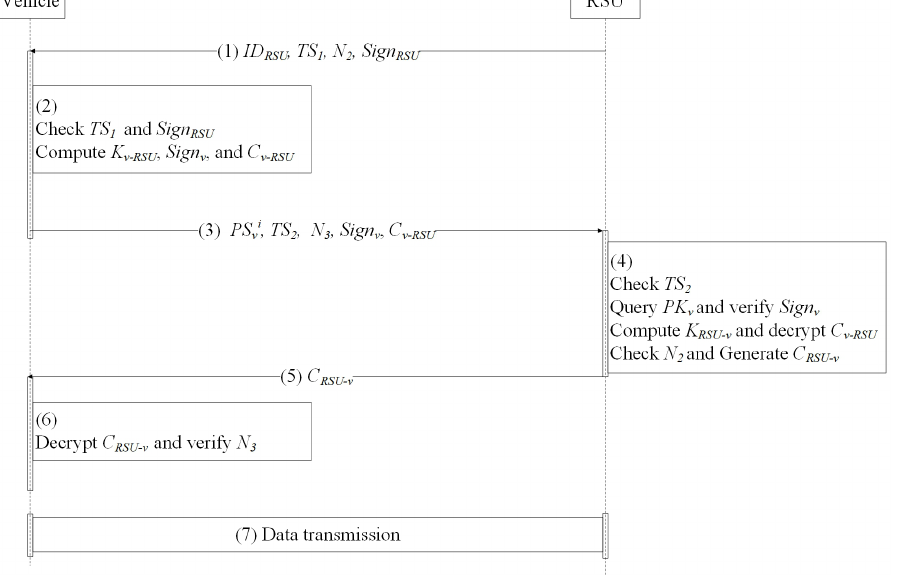
Figure 5. V2I authentication